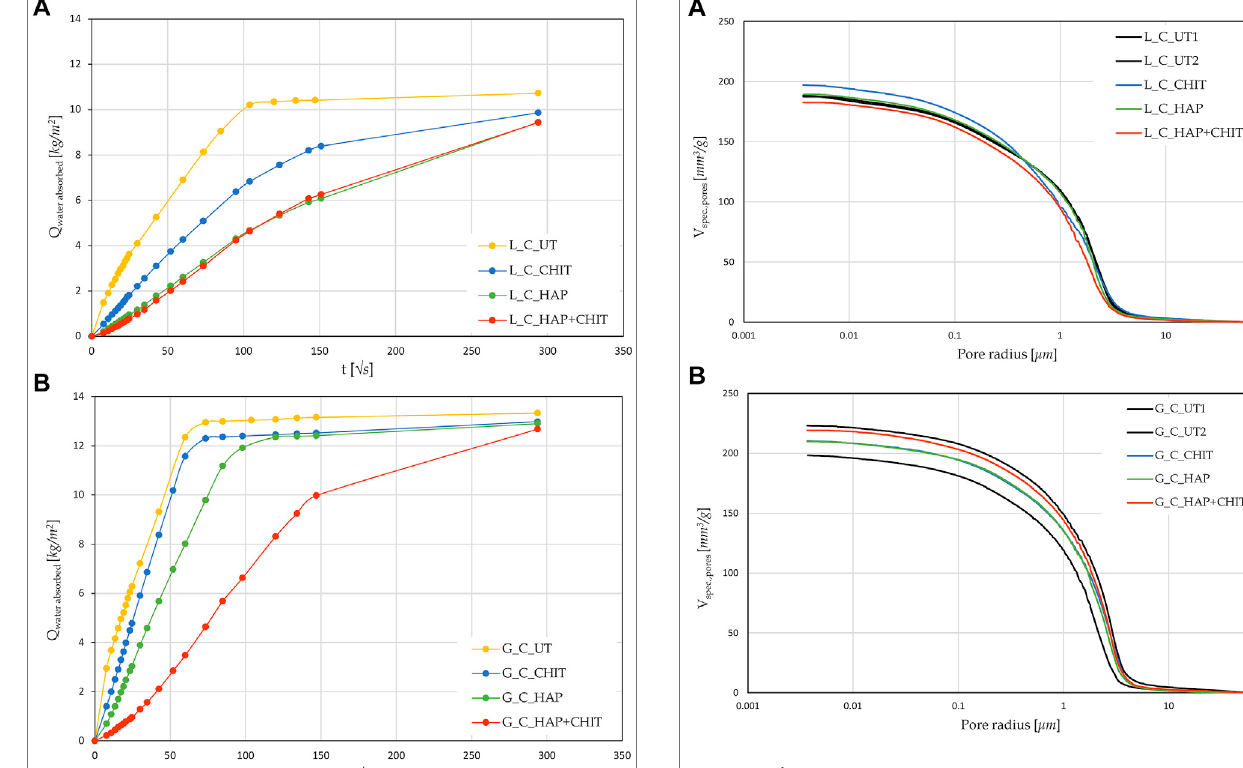
FIGURE 2 | Pore size distribution of various type of stone samples, obtained with MIP test, compared to the relative UT samples, for (A) Lecce stone and (B) Globigerina